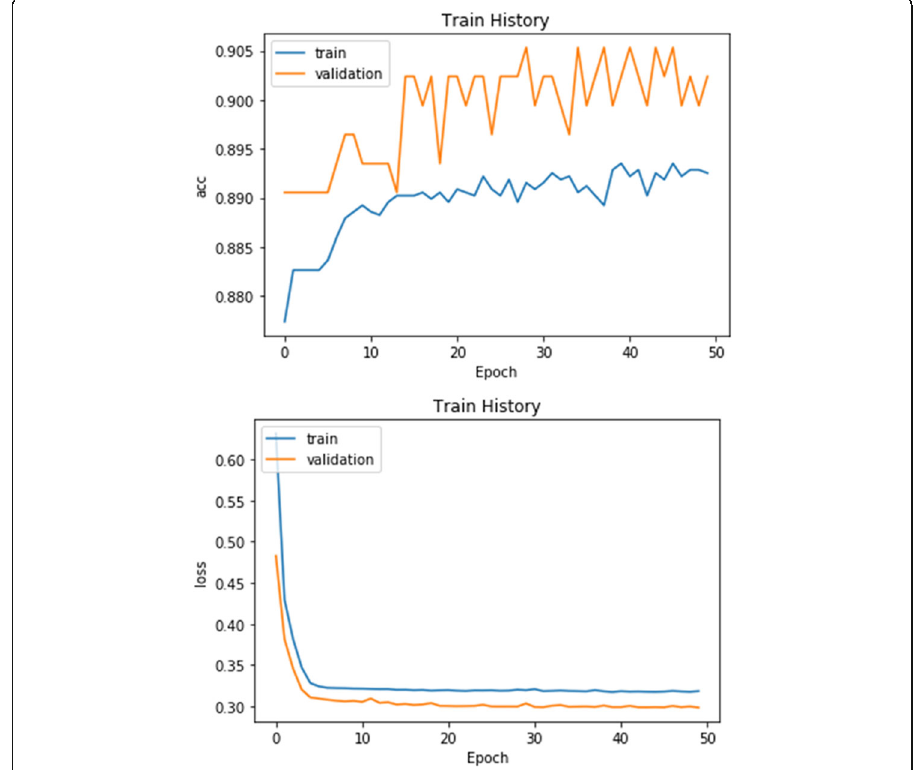
Fig. 2 Training process of the multilayer perceptron model (for accuracy and